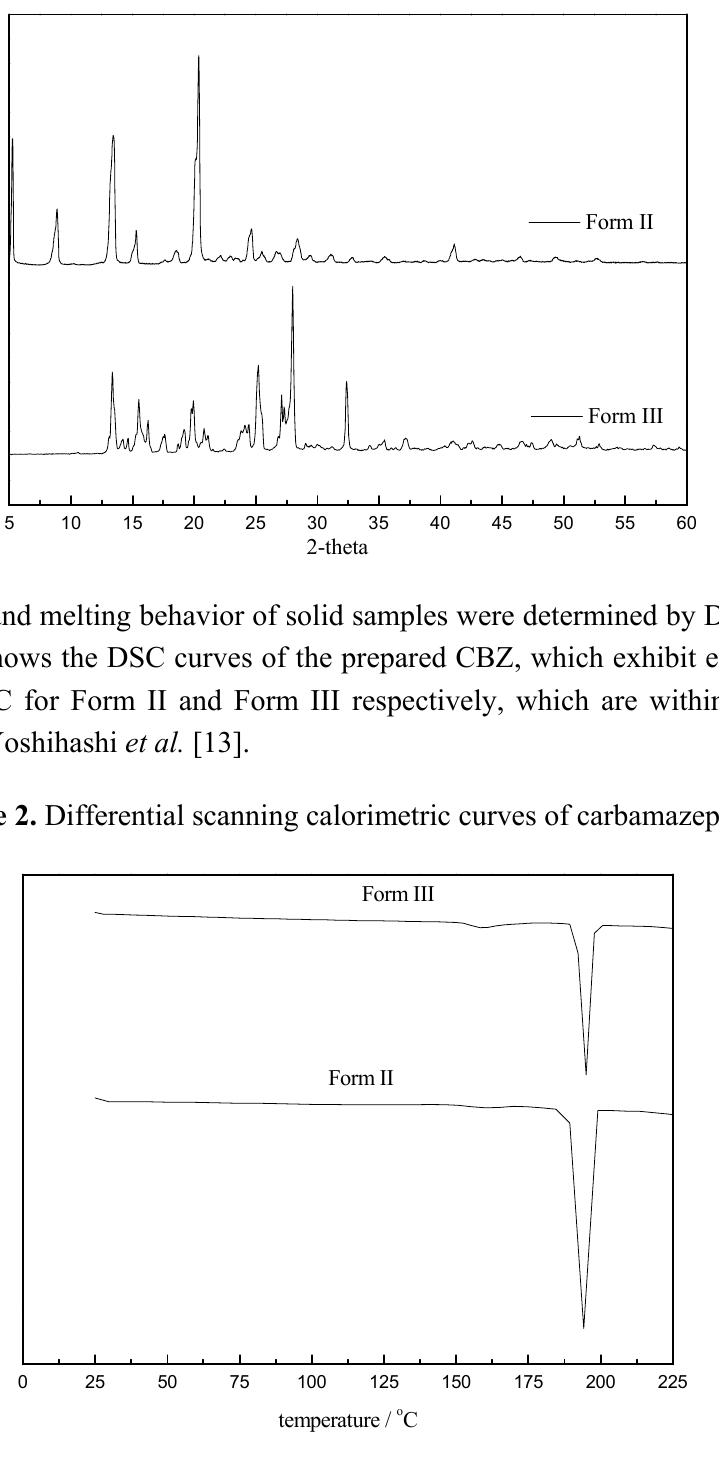
Figure 1. X-ray diffraction patterns of carbamazepine Form II and III.